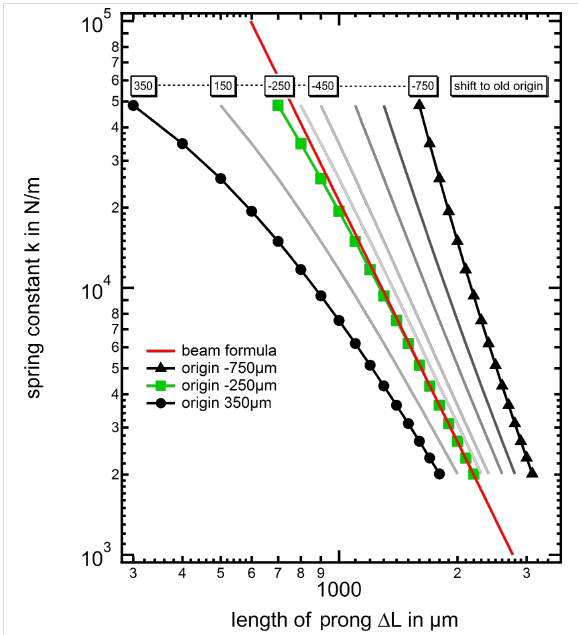
Figure 6: Diagram showing the results of the FEM simulation as a function of the shift of the origin. While for too large or too small chosen positions of the origin the curves show a non linear behavior, the a Δ L − 3 behavior can be identified in the transition regime for a new effective origin position of approx. L 0 = − 250 μ m.